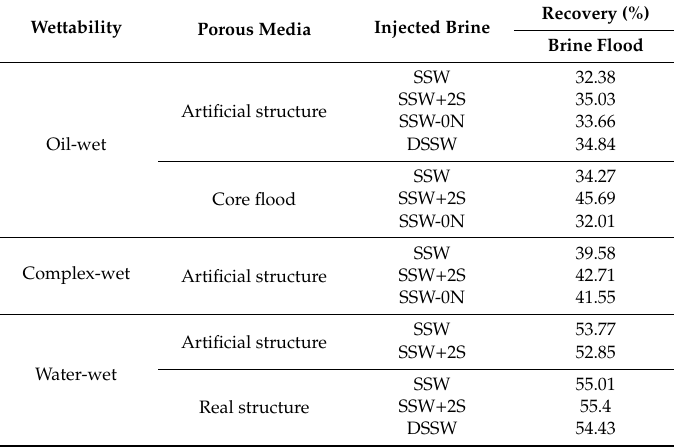
Table 13. Comparison of oil recoveries through both types of micromodels and core flood with different wettability. Recovery factors mentioned are only through secondary mode brines flood.